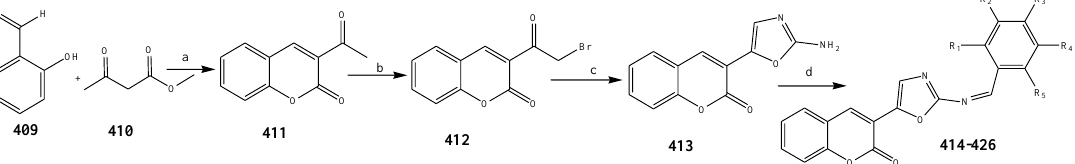
Scheme 34. Synthesis of benzothiazole and benzoxazole linked 1,4-disubstituted